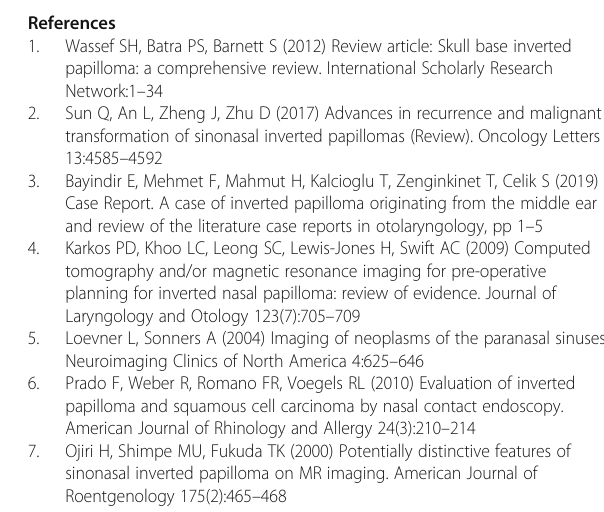
retention cyst, and showing better visibility in post- gadolinium contrast-enhanced images (as observed in our study). Also, presence of remodeling bony changes and smooth non-erosive resorptions are adding to the diagnostic yield of preoperative imaging study.